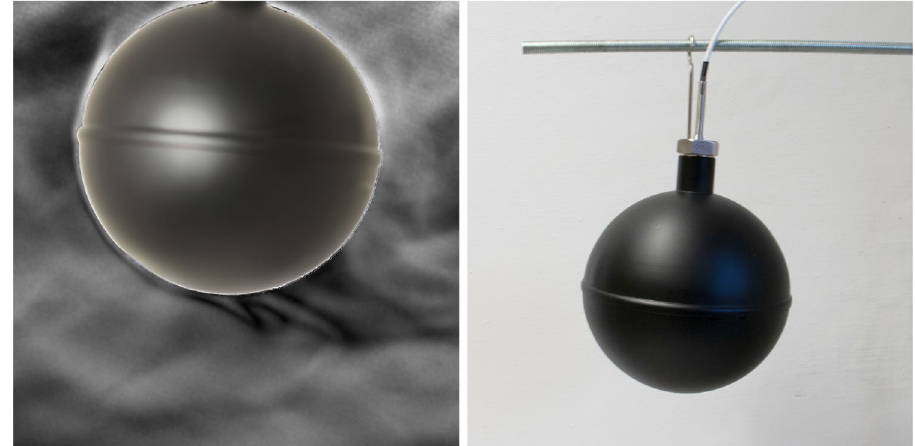
Figure 2. Background oriented schlieren imaging (left) of the globe thermometer setup (right) accentuating air density variation to illustrate air movement and convection around the globe. Dark lines at the bottom represent cool free convection separating from the